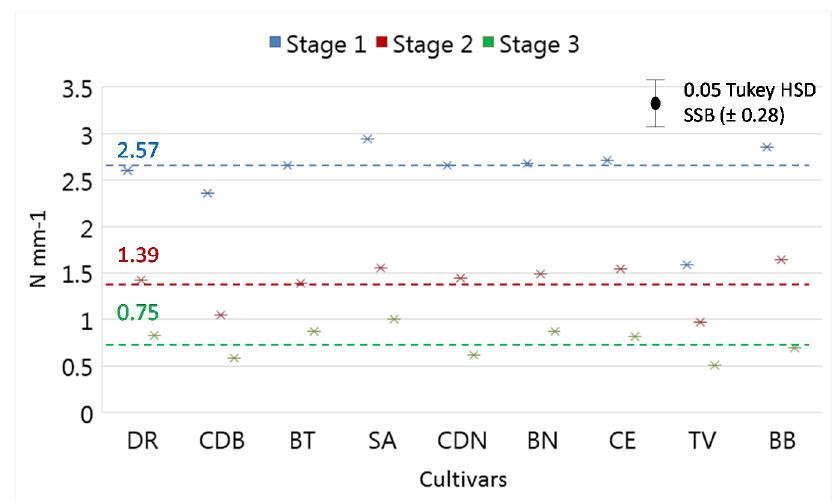
Figure 3. Firmness values of the fig cultivars at the three ripening stages studied.